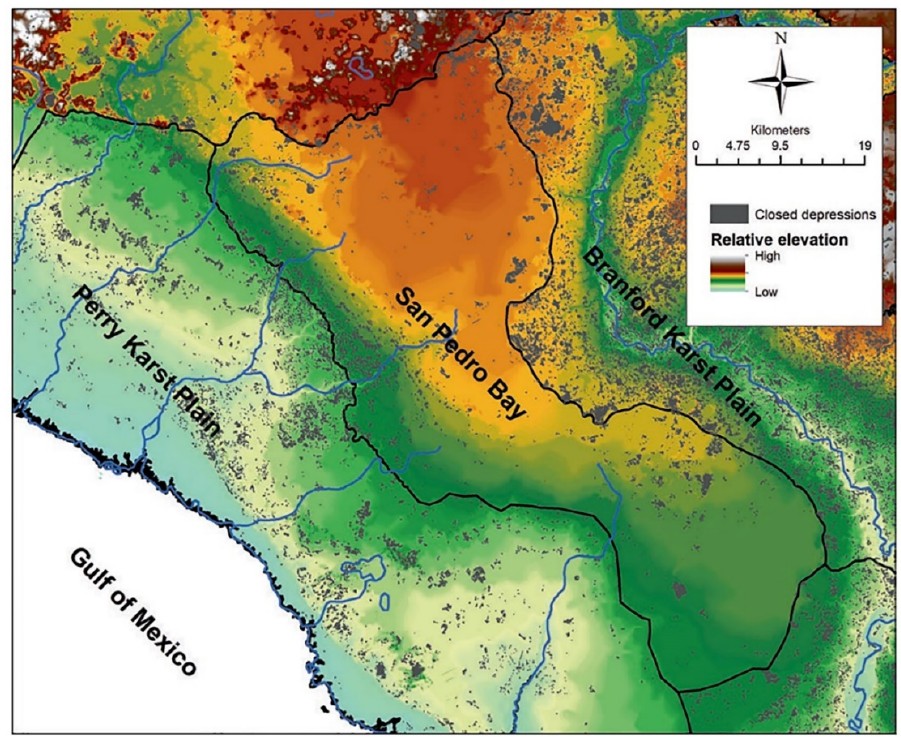
Figure 15. Depressions of coastal karst, which have areal pattern [18].